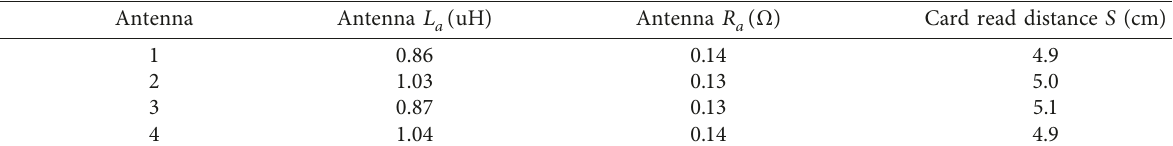
Table 1: Antenna read-write distance.